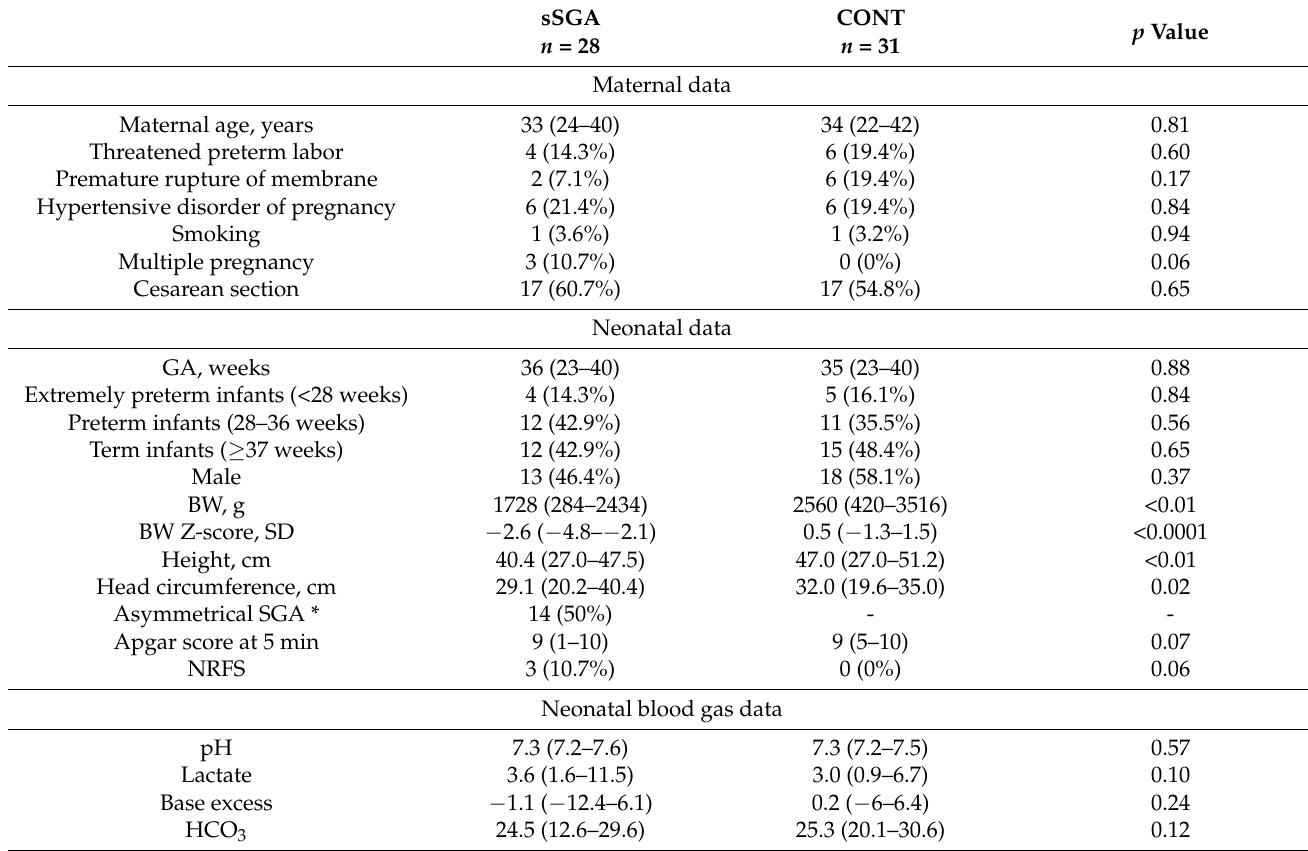
Table 1. Clinical characteristics of sSGA and control